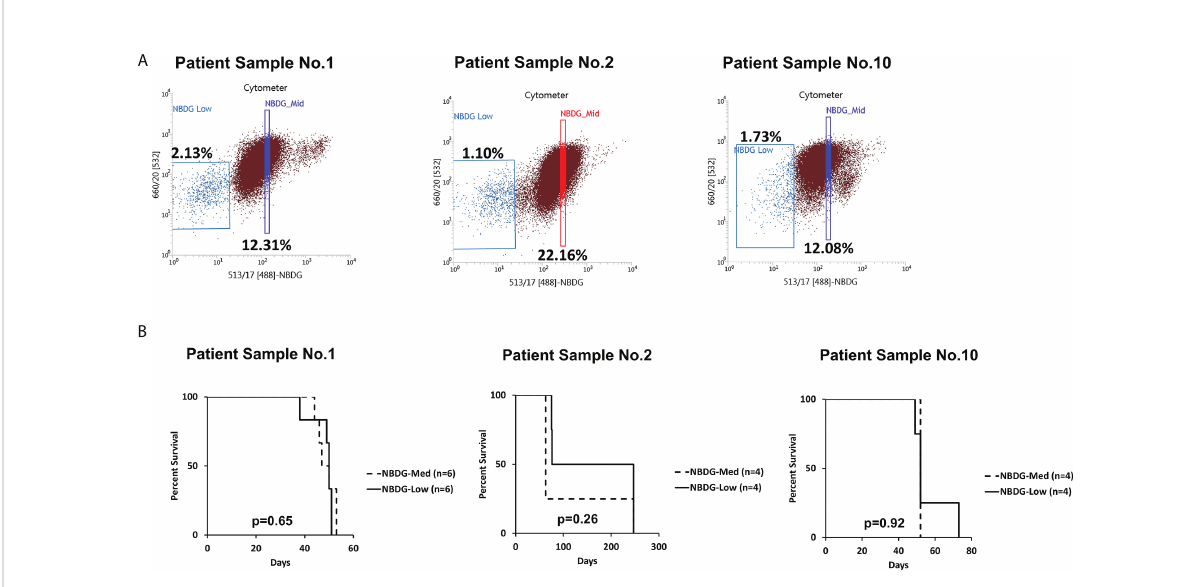
FIGURE 2 The NBDG-med population also initiates leukemia in vivo . (A) The NBDG-med population has intermediate NBDG uptake and lies in between the NBDG-low population and the NBDG-high population (not labeled; see Figure 1B). (B) In three separate experiments with the three patient samples described in (A) , mice that were transplanted with NBDG-med developed leukemia at a nearly identical rate to the NBDG-low mice, with overall median survival of 52 days for NBDG-med compared to 51.5 days for NBDG-low. 5000 cells were transplanted per